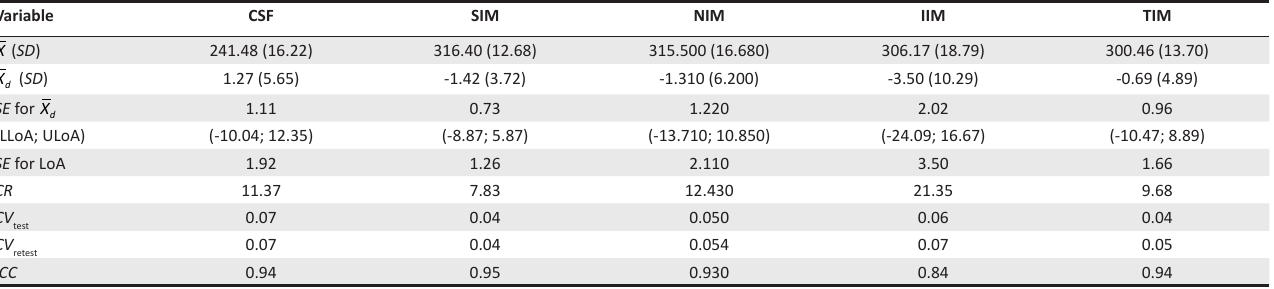
TABLE 3: Descriptive statistics for the Bland–Altman plots for retinal thickness in the central subfield/fovea, superior inner macular, nasal inner macular, inferior inner macular and temporal inner macular. Variable CSF